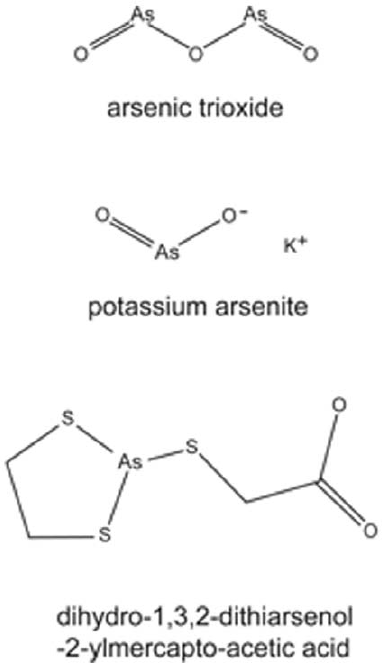
Figure 1. Chemical structures of arsenic trioxide, potassium arsenite, and dihydro-1,3,2-dithiarsenol-2ylmercapto-acetic acid.